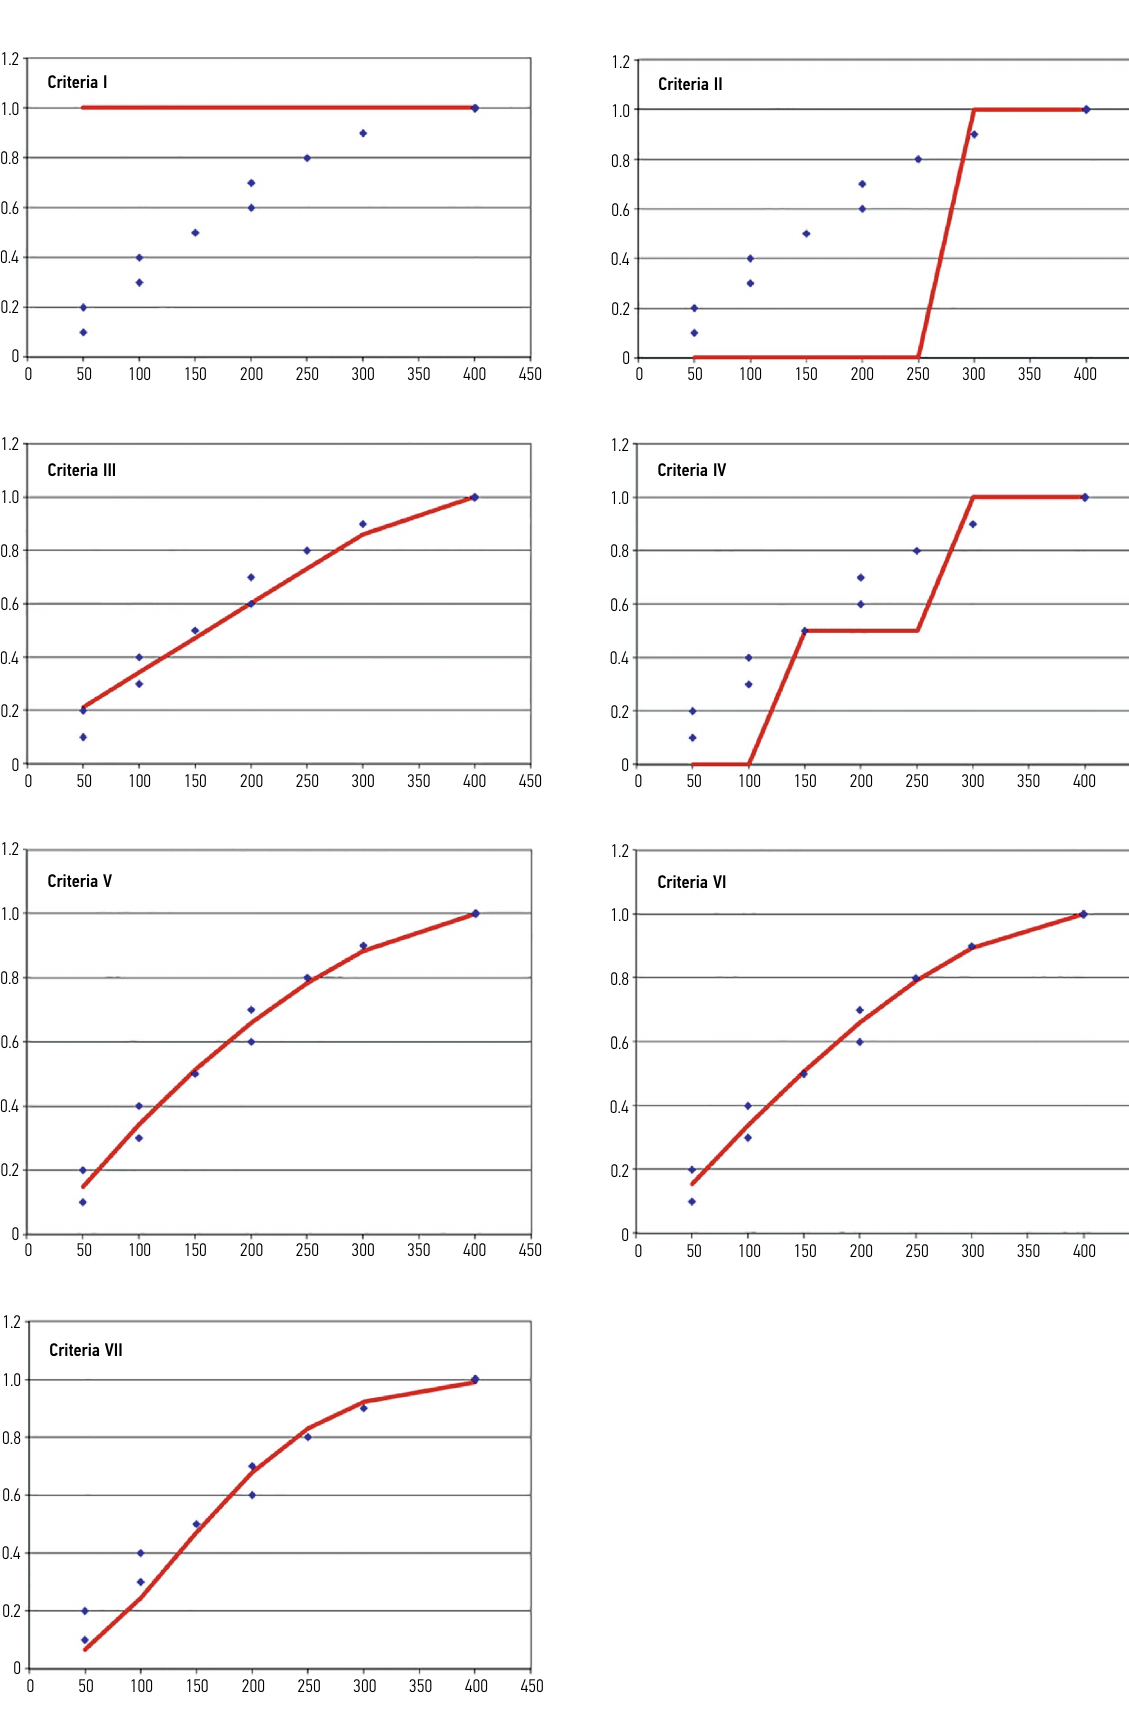
Fig. 5. Shapes of generalized functions which describe experimental points for criterion k